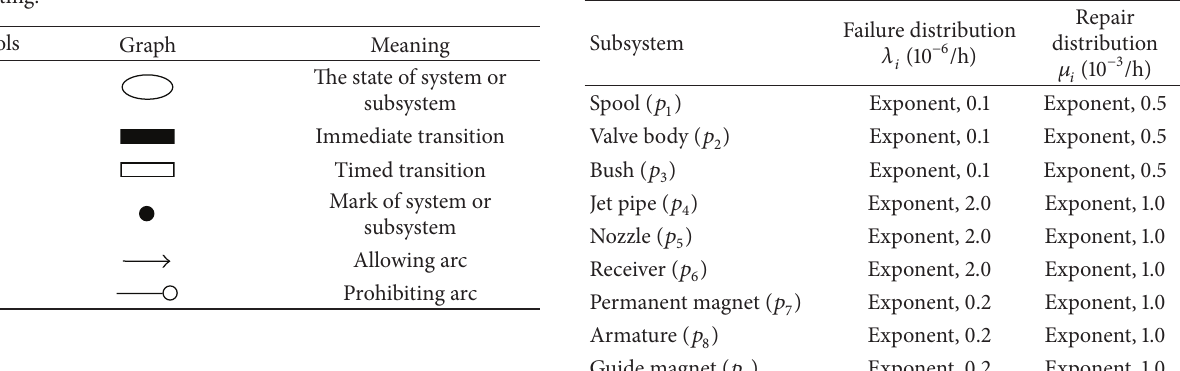
Table 1: The meaning of symbols during reliability modeling and simulating.